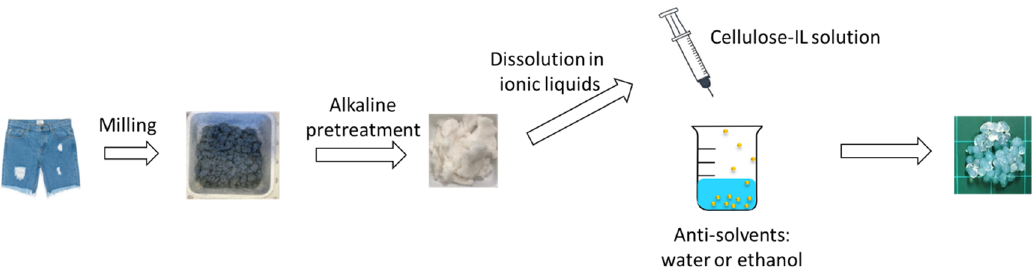
Figure 1. A schematic for the preparation of cellulose beads from waste denim.